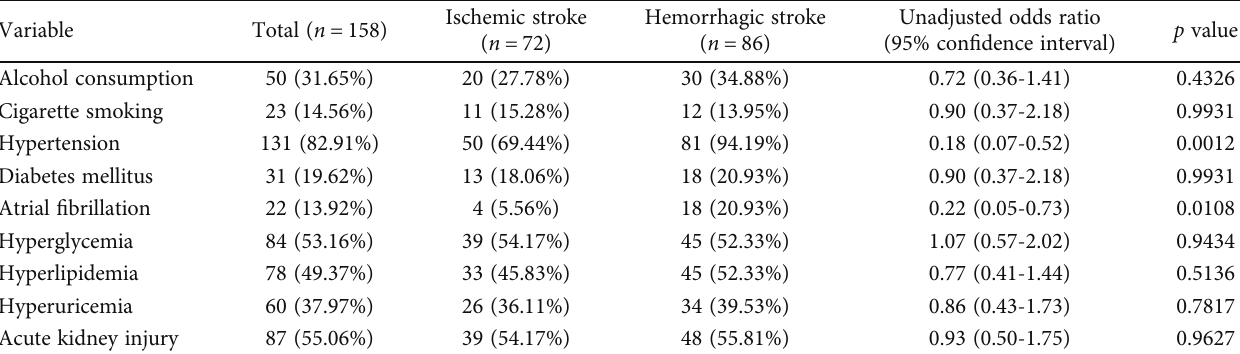
Table 3: Prevalence of comorbid risk factors of stroke.